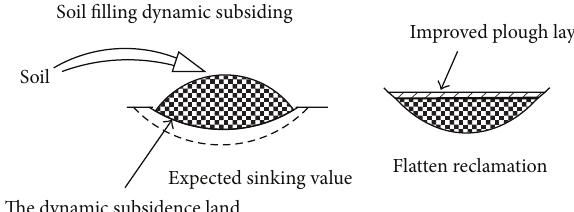
Figure 3: The dynamic prereclamation schematic diagram of soil backfilled collapse.